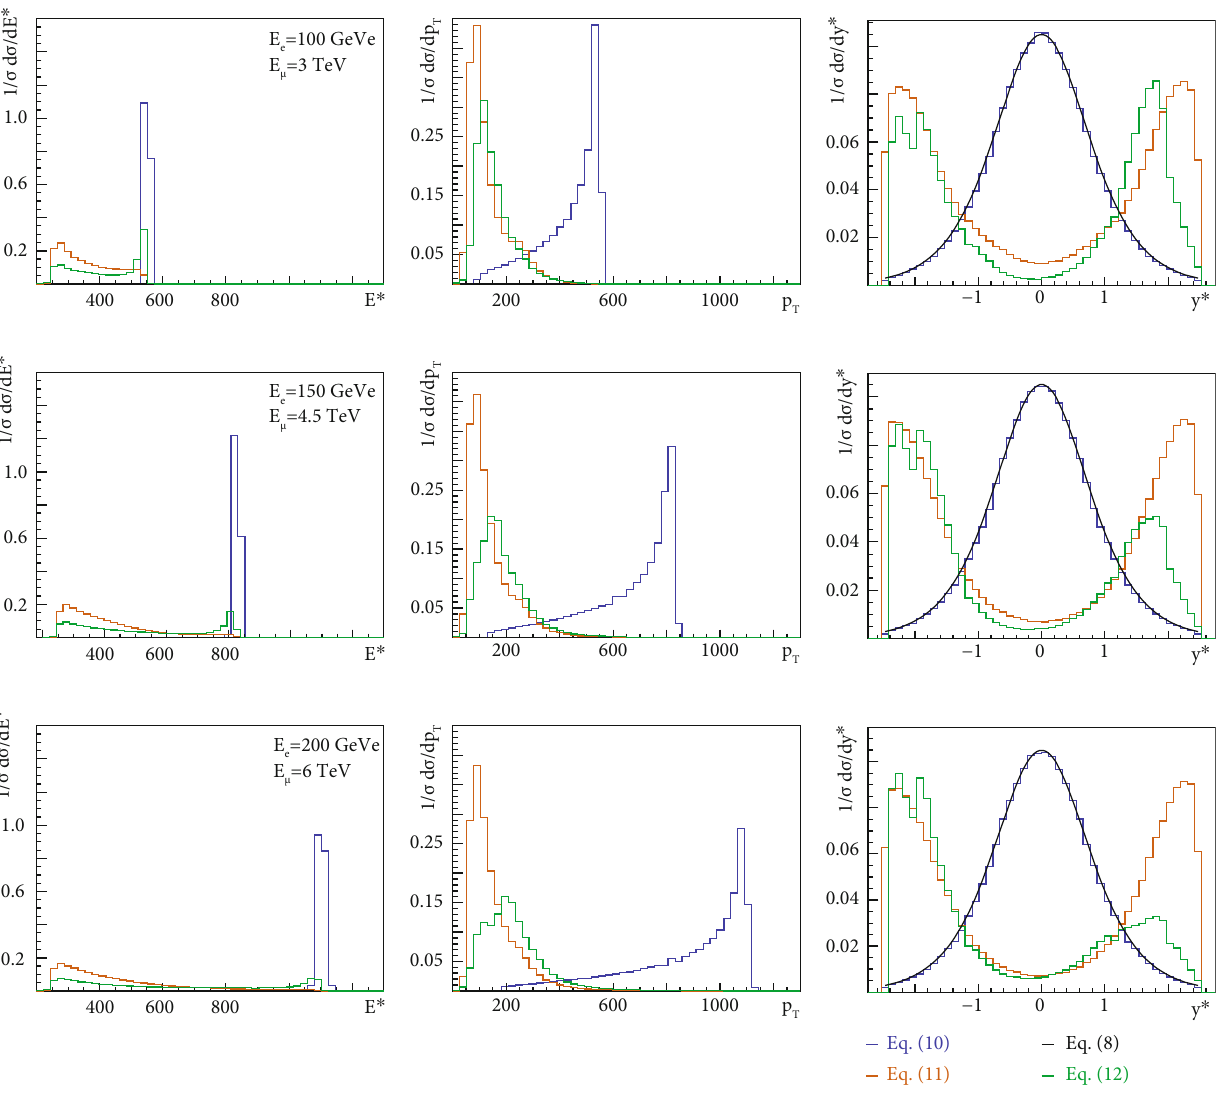
Figure 3: Normalized di ff erential cross sections for fi nal-state photons for processes (14) and (15) and e ± for process (16), with respect to center-of-mass energy (a), transverse momentum (b), and center-of-mass rapidity (c). The beam energies are ð E (upper row), (150GeV, 4.5TeV) (middle row), and (200GeV, 6 TeV) (lower row). Blue lines: signal process (14); black line: analytical expression (12); orange lines: background process (15); green lines: background process (16). All di ff erential cross section correspond to detector-level events with cuts (18).